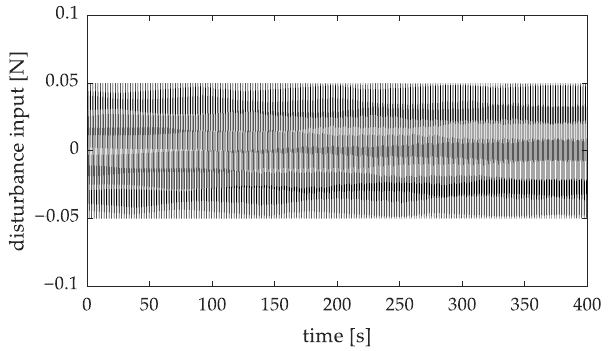
Figure 5. The disturbance input signal that was applied in the